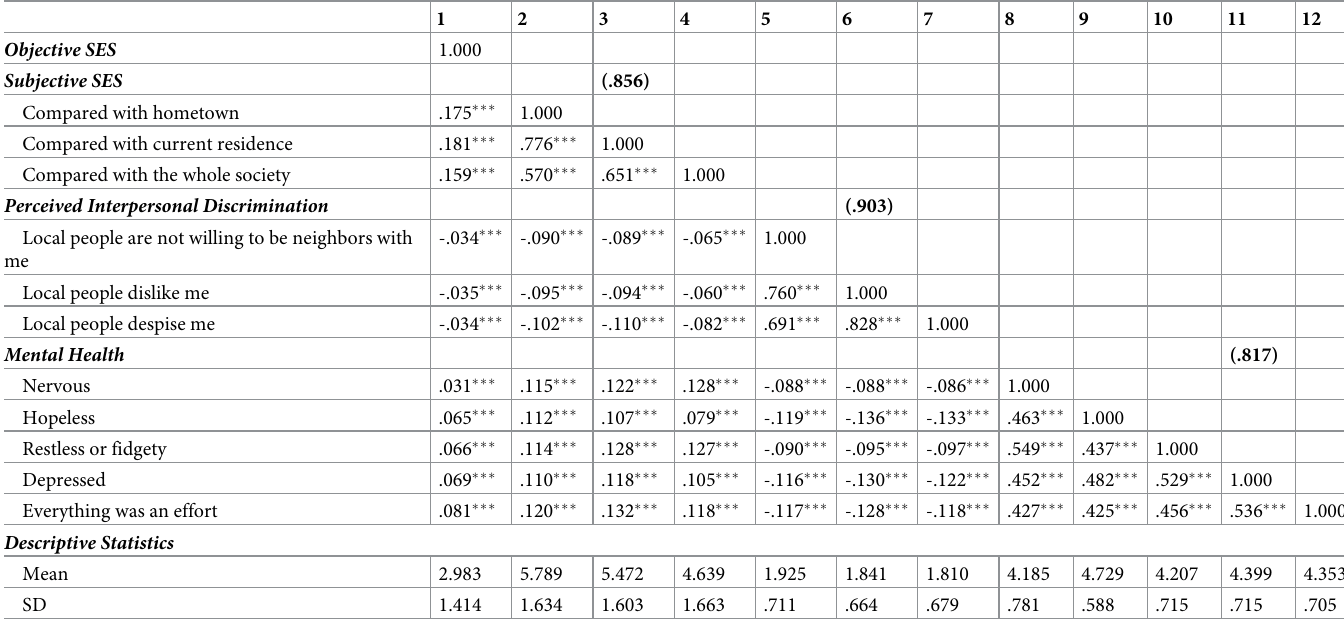
Table 3. Descriptive statistics and correlation coefficients of the indicator variables (N =